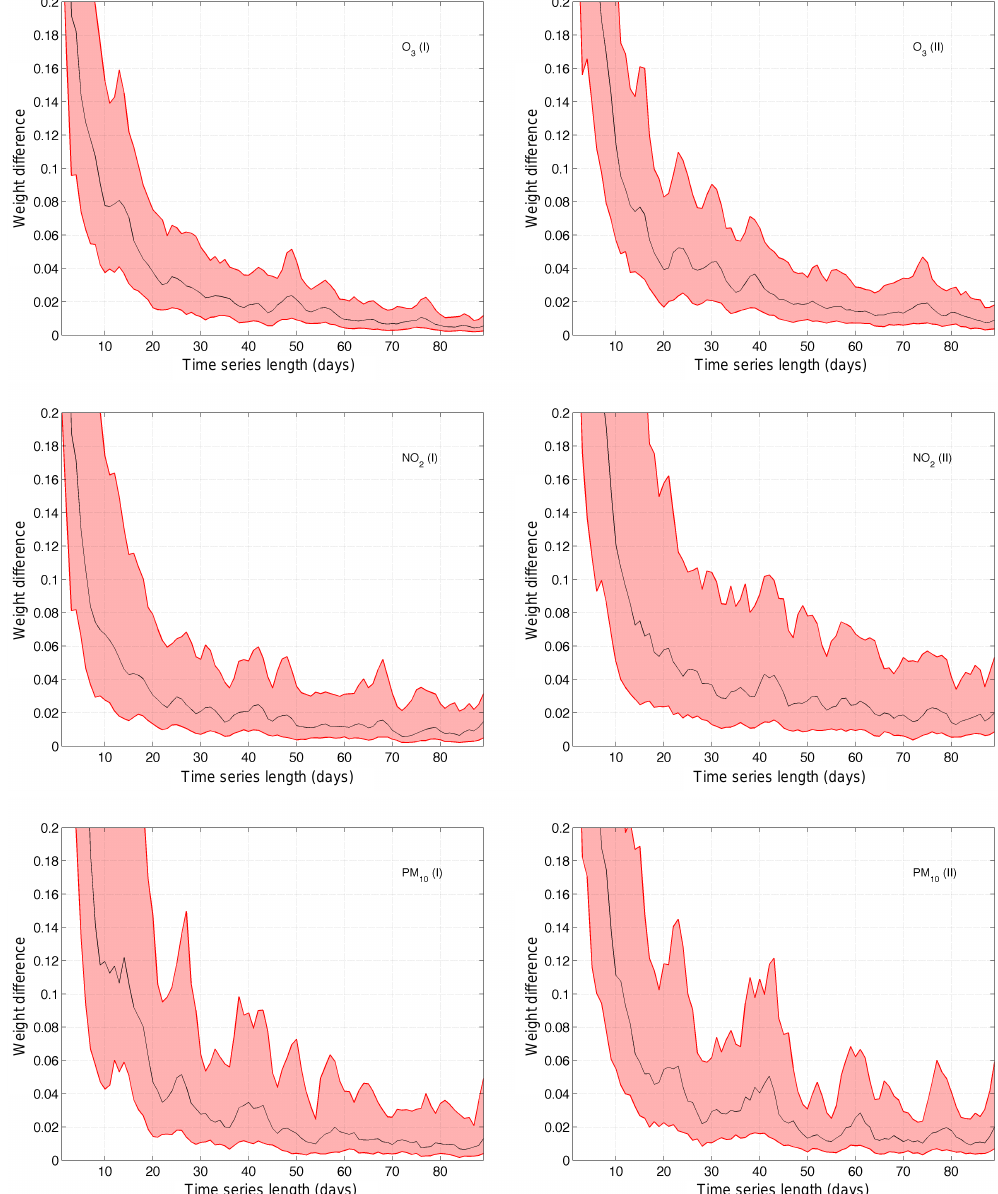
Figure 10. The interquartile range over all stations of the day-to-day difference in the weights arising from variable time series length.